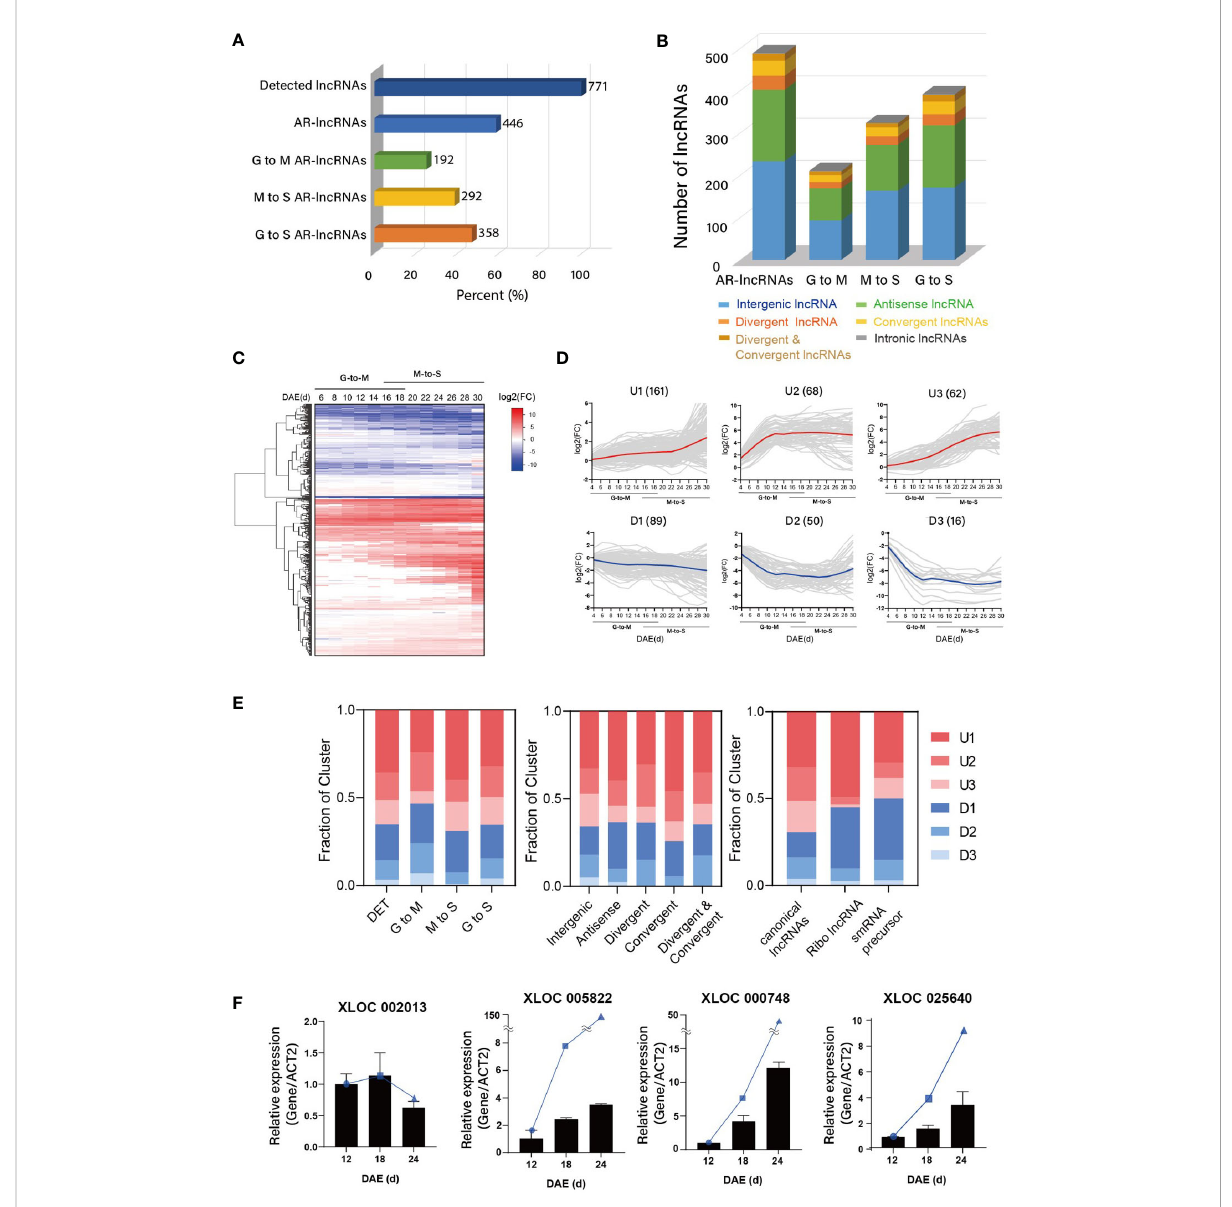
FIGURE 2 Identi fi cation of age-related lncRNAs (AR-lncRNAs) in Arabidopsis . (A) Proportions of lncRNAs detected in the reconstructed leaf transcriptome and differentially expressed in aging leaves (fold change ≥ 2, p <= 0.05). The leaf lifespan was divided into two developmental stages, G-to-M (Growth to Maturation, 4 – 18 d) and M-to-S (Maturation to Senescence, 16 – 30 d). Some of G-to S AR-lncRNAs are overlapped with G-to-M AR- lncRNAs or M-to-S AR-lncRNAs. (B) Proportions of AR-lncRNAs at different genomic locations with respect to the nearest protein-coding gene. (C) Heat maps showing the expression of AR-lncRNAs over the entire leaf lifespan. Rows are ordered based on hierarchical clustering. Color bar represents the gradient of log2(fold change) values relative to the 4-DAE time point. DAE: days after emergence. (D) Changes in AR-lncRNA transcript levels in aging leaves, as shown by k-means clustering. Six major clusters (upregulated, U1 – U3; downregulated, D1 – D3) were detected, depending on AR-lncRNA expression patterns. (E) Proportions of major AR-lncRNAs in different categories established based on the different developmental stages of leaves and the genomic locations and functions of AR-lncRNAs. (F) Expression analysis of novel AR-lncRNAs at three timepoints by qRT-PCR. Error bars represent the standard error of mean (SEM; n = 3). The blue circles, squares, and triangles means the TPM value of each lncRNA at indicated leaf ages (12d, 18d, 24d) from